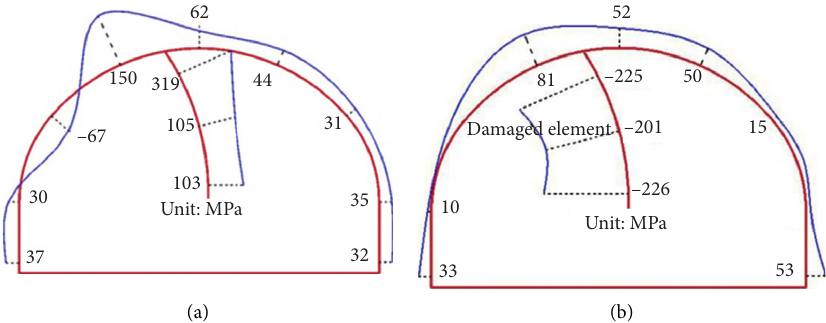
Figure 9: Stress distribution of steel rib at YK2+449 section. (a) Maximum stress outside the steel rib. (b) Maximum stress inside the steel rib.